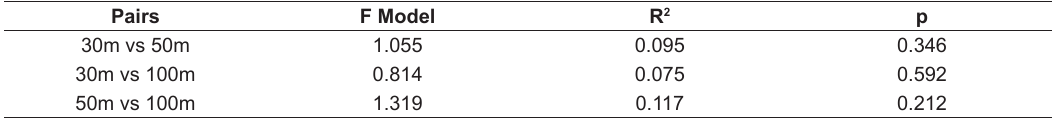
Table 4. PERMANOVA pairwise contrasts comparing the taxonomic composition of benthic macroinvertebrate assemblages.